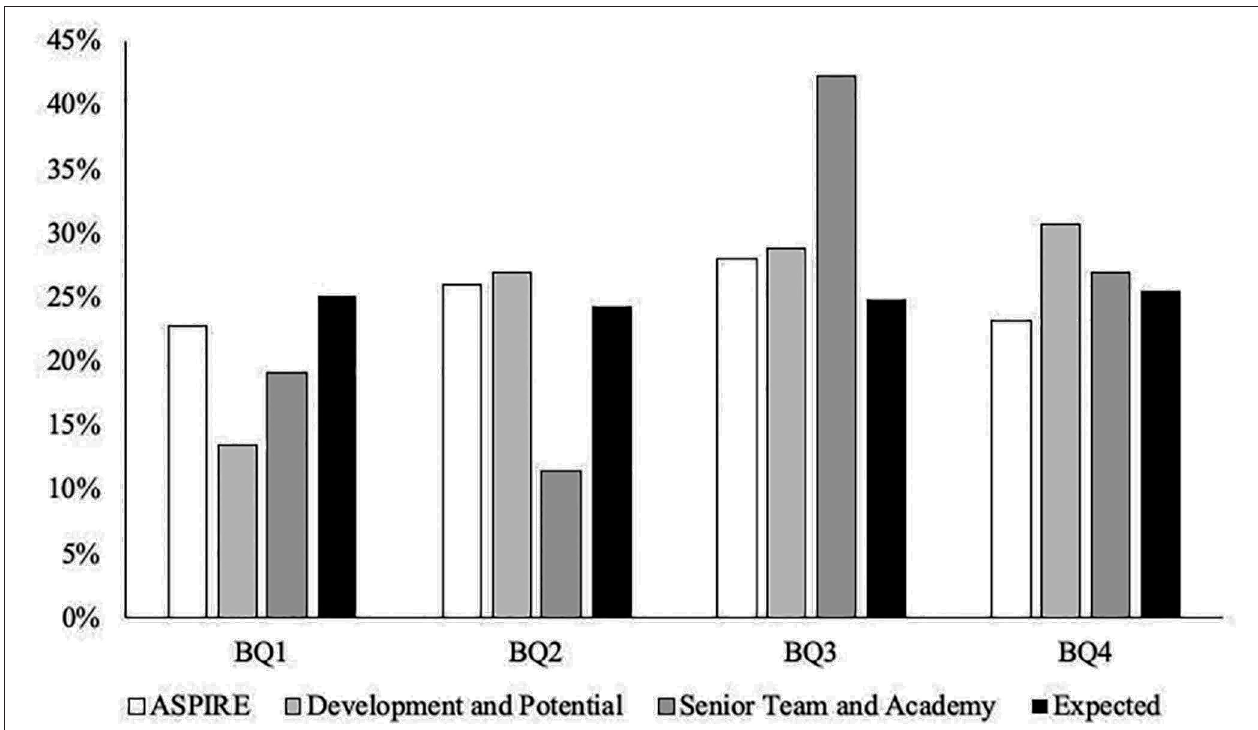
FIGURE 2 | The distribution of BQs in athlete’s respective cohort and expected distribution from national norms (Office for National Statistics, 2015).